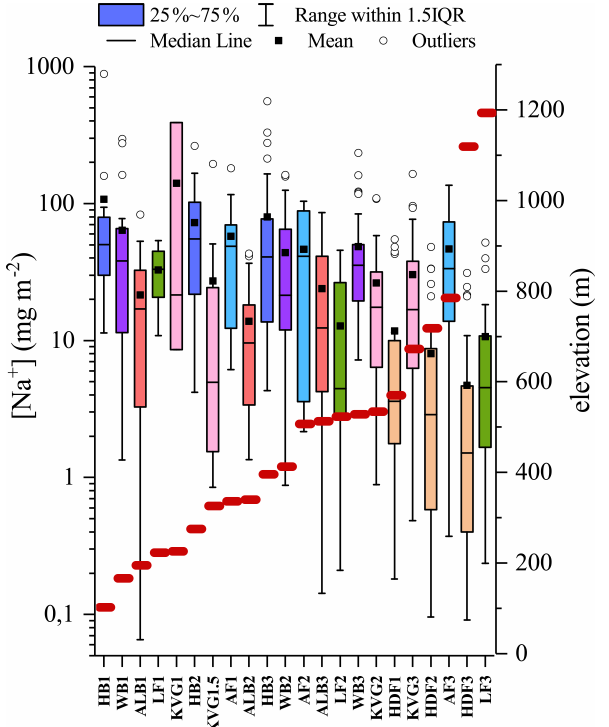
Figure 6. Sodium load in snowpits ordered by increasing eleva- tion in ma.s.l., indicated by the red lines. The colours identify areas where the snowpits have been excavated: each colour represents a separate glacier (HB – blue; WB – purple; ALB – red; LF – green; KVG – pink; AF – light blue; HDF – orange). IQR = inter-quartile range, i.e. the difference between the values of quartiles 3 and 1.